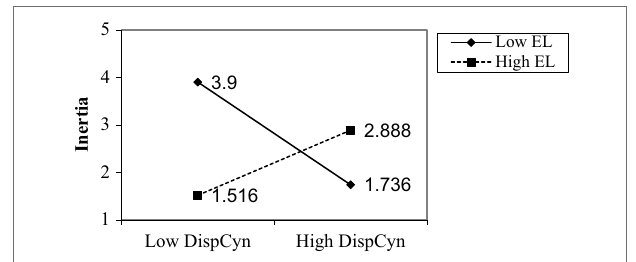
FIGURE 3 | The effect of cynicism towards change on inertia at various levels of empowering